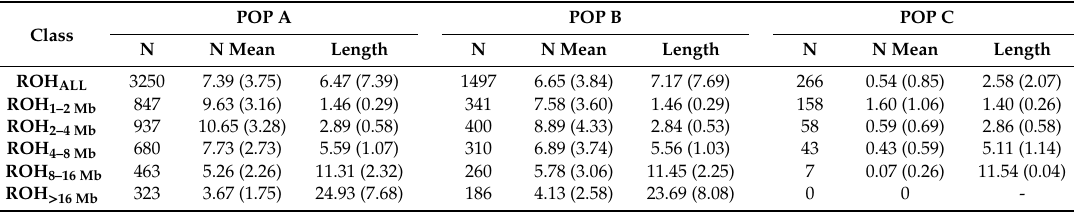
Table 1. Total number of runs of homozygosity (ROH) (N) per class, the average number of ROH per individual (N Mean) and average length (Mb) considered all ROH and by classes for three coho salmon populations.